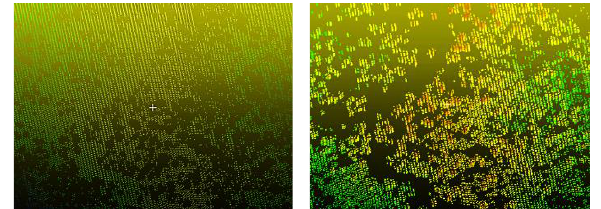
Figure 3. ( a) Ground points, (b) non-ground points